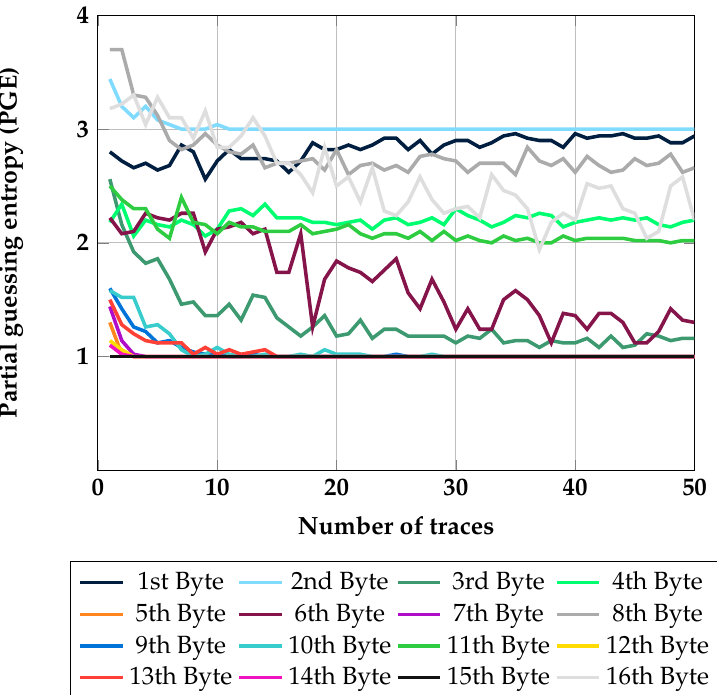
Figure 6. Results for the keyless template-based SPA when computing a key schedule in a block cipher AES with no